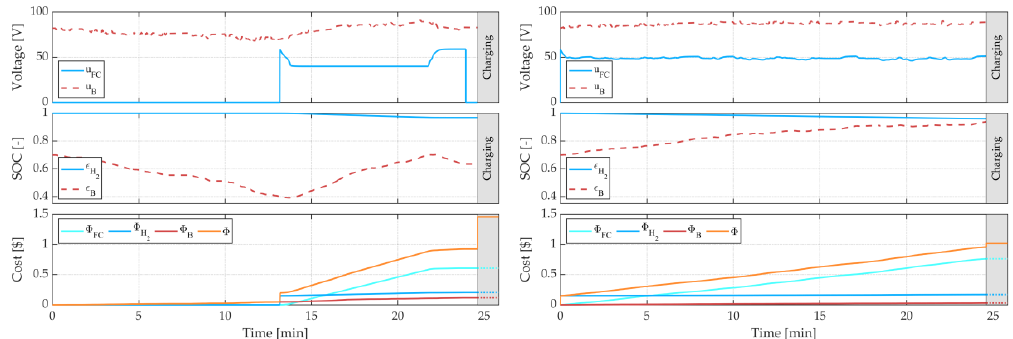
Figure 18. Voltages, state-of-charge and costs achieved over WLTC by H-EMS ( left ) and S-EMS ( right ).